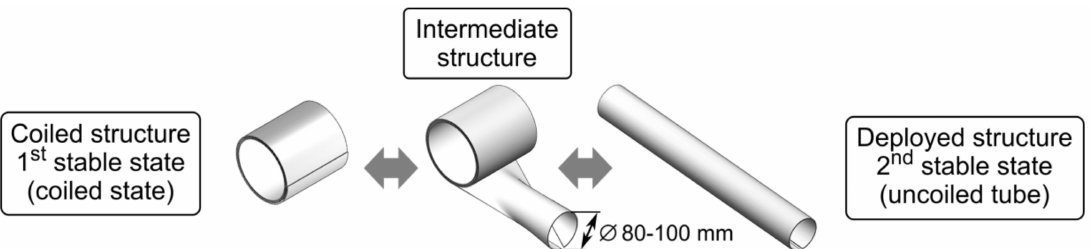
Figure 1. Schematic representation of a fully closed bistable shell.